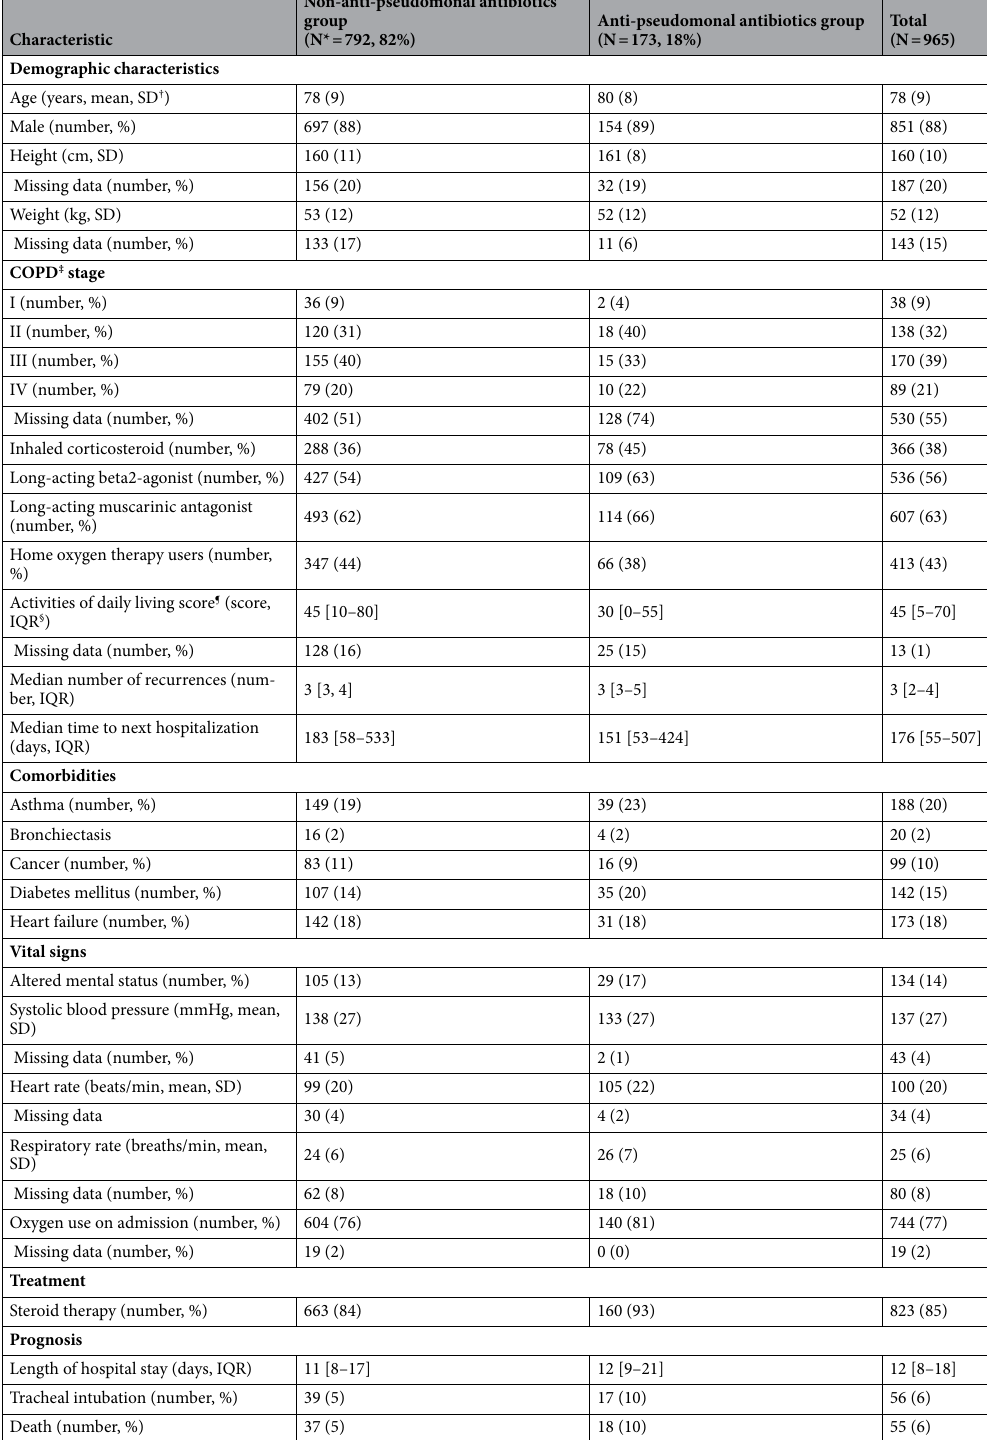
Table 1. Patient characteristics per observation. *: N = number; †: SD = standard deviation; ‡: COPD = chronic obstructive pulmonary disease; § IQR = interquartile range; ¶: Activities of daily living score is defined as the Barthel index. A high score indicates a higher activity